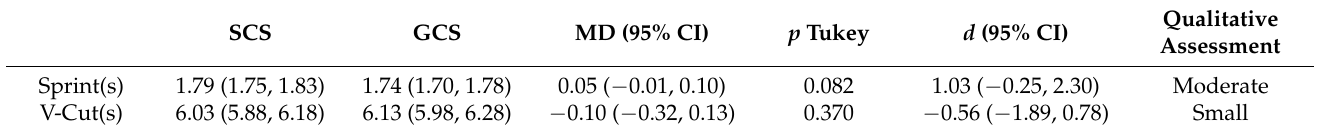
Score values of both groups are presented as estimated means with a 95% confidence interval. SCS: specific CORE stability intervention group; GCS: general CORE stability intervention group; d : Cohen’s d effect